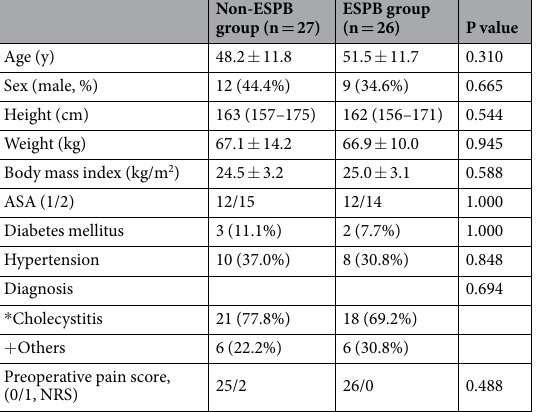
Table 1. Patients demographics. Values are expressed as the mean ( ± SD) or median (interquartile range) for continuous variables, and n (%) for categorical variables. * Cholecystitis: Preoperatively diagnosed as acute or chronic cholecystitis; + Others: Preoperatively diagnoses other than cholecystitis, which includes gallbladder stone, gallbladder polyp, and adenomyomatosis. NRS: numeric rating scale.